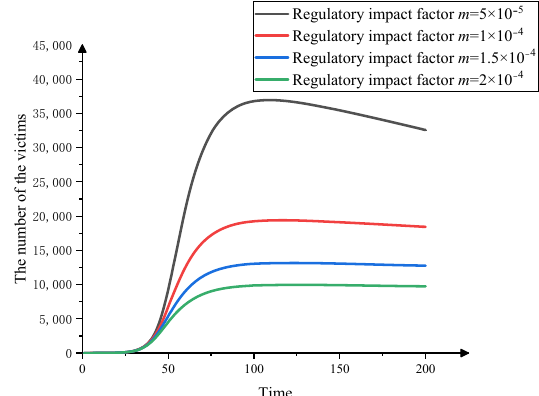
Figure 12. Impact of regulatory impact factor on fraud dissemination.